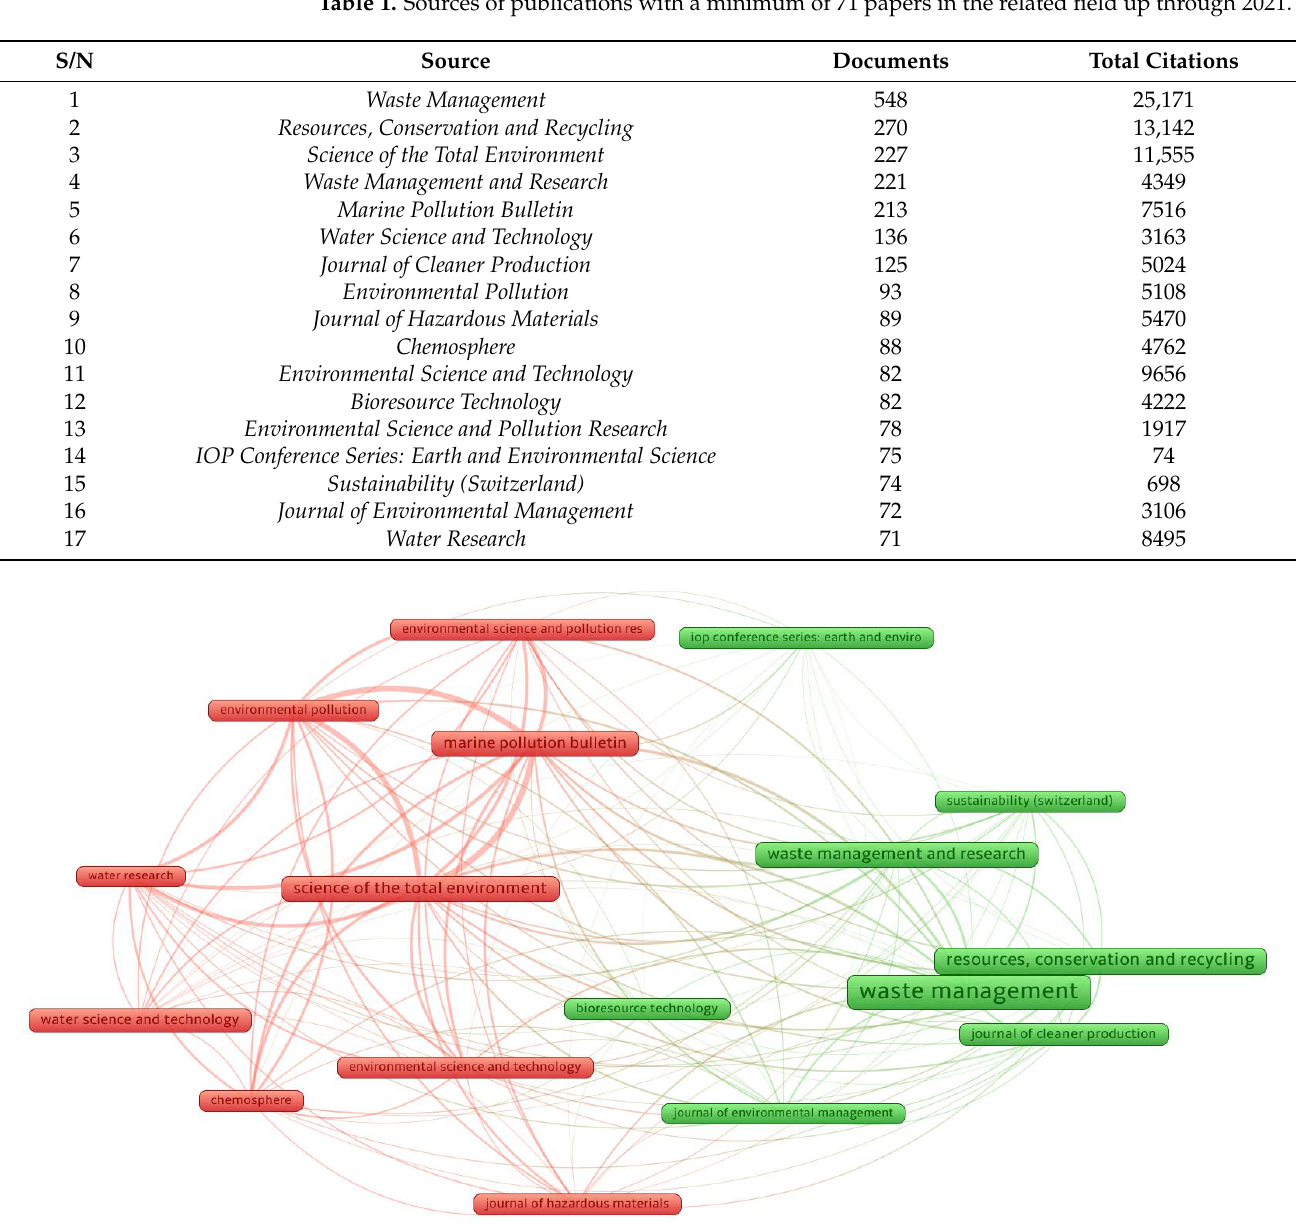
Figure 6. Science mapping of publication sources with a minimum of 50 articles in the relevant study area. Box size is proportional to the number of articles published in a particular journal, and color refers to the clustering of journals based on co-citation patterns in the published articles.